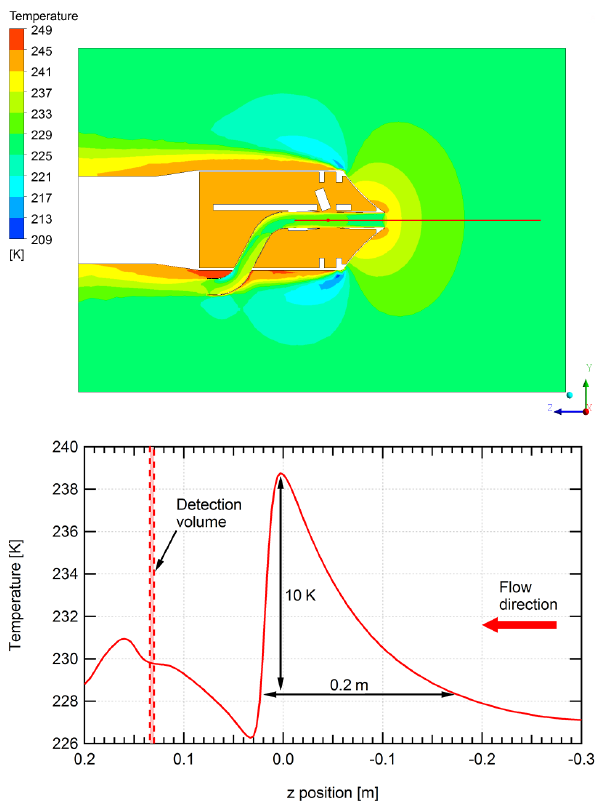
Figure 6. Temperature distribution inside and outside the probe (up- per panel) and along the centre line trajectory (lower panel). Incom- ing particles experience a short-term temperature change of the sur- rounding air by about 10K within 1ms at 200ms − 1 flight speed.